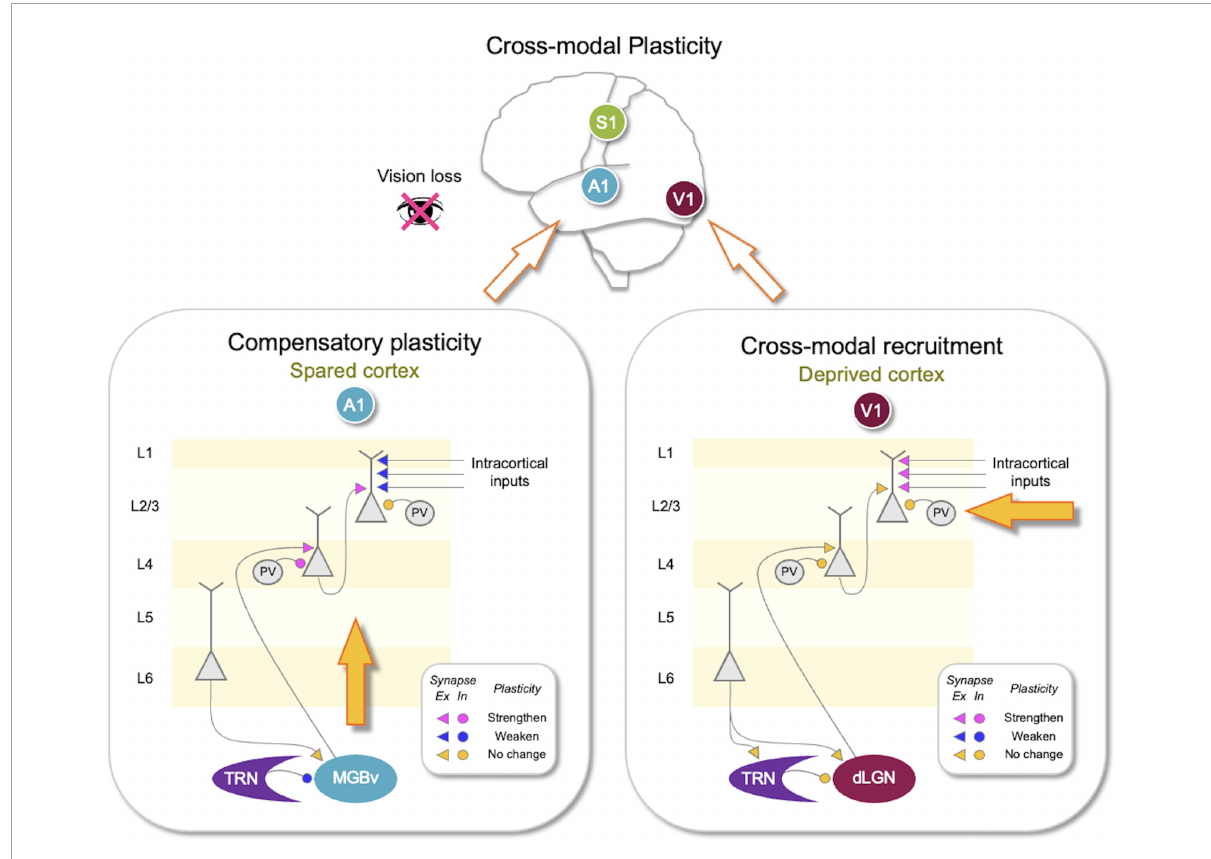
FIGURE1 Synaptic changes associated with adult cross-modal plasticity. Sensory loss produces compensatory plasticity in the spared sensory cortices and cross-modal recruitment plasticity in the deprive sensory cortex. Lower panels show compilation of synaptic plasticity data from adult mice after vision loss (Petrus et al., 2014, 2015; Whitt et al., 2022). (Lower right panel) In the deprived primary visual cortex (V1), there is no plasticity of the feedforward (thalamocortical inputs to L4 and L4–L2/3) or the thalamic circuit, but lateral inputs to L2/3 potentiate. There is no change in parvalbumin (PV) inhibition onto L4 or L2/3 neurons. Corticothalamic synapses from V1 to thalamic reticular nucleus (TRN) or the primary visual thalamus [dorsal lateral geniculate nucleus (dLGN)] did not change. Adaptation of V1 circuit could allow cross-modal recruitment of V1 for processing other sensory inputs arriving through the potentiated lateral inputs to L2/3. (Lower left panel) In the spared primary auditory cortex (A1), there is potentiation of the feedforward synapses, including thalamocortical synapses and L4–L2/3 synapses. The strength of lateral inputs to L2/3 is weakened. Cortical inhibition mediated by PV neurons becomes stronger in L4 but does not change in L2/3. In addition, there is plasticity in the thalamic circuit, where TRN inhibition to the primary auditory thalamic nucleus [ventral portion of medial geniculate body (MGBv)] is reduced. Corticothalamic synapses to MGBv were not altered. Such adaptation of A1 is expected to amplify auditory signals and allow sharpening of tuning properties to mediate compensatory plasticity. Plasticity of synaptic strength following vision loss is color coded as shown in the insets. Pink, potentiated synapses; Blue, depressed synapses; Yellow: no change in synaptic strength. Triangles, excitatory ( Ex ) synapses; Circles, inhibitory ( In )